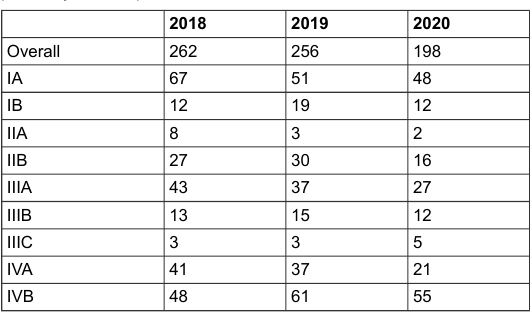
Table 2: Annual distribution of non-small cell lung cancer (NSCLC) cases re- ported by the comprehensive cancer centre